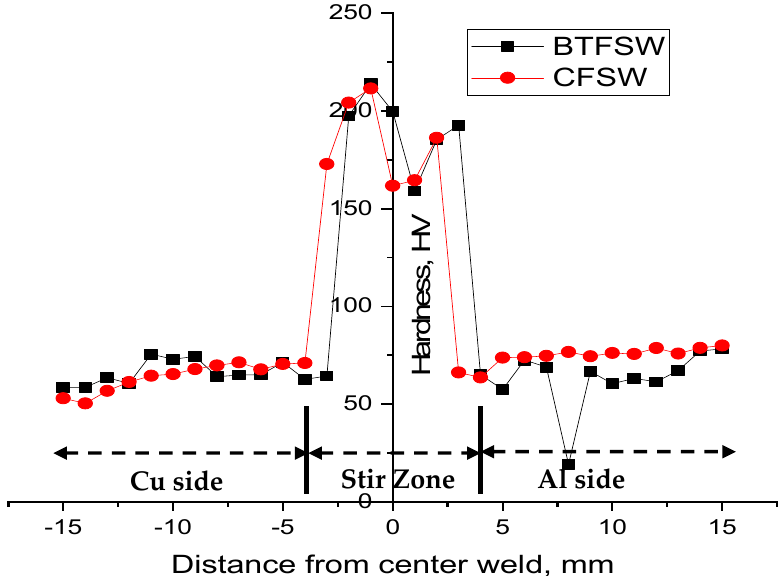
Figure 8. Microhardness of dissimilar Al/Cu joint produced by FSW and BTFSW.